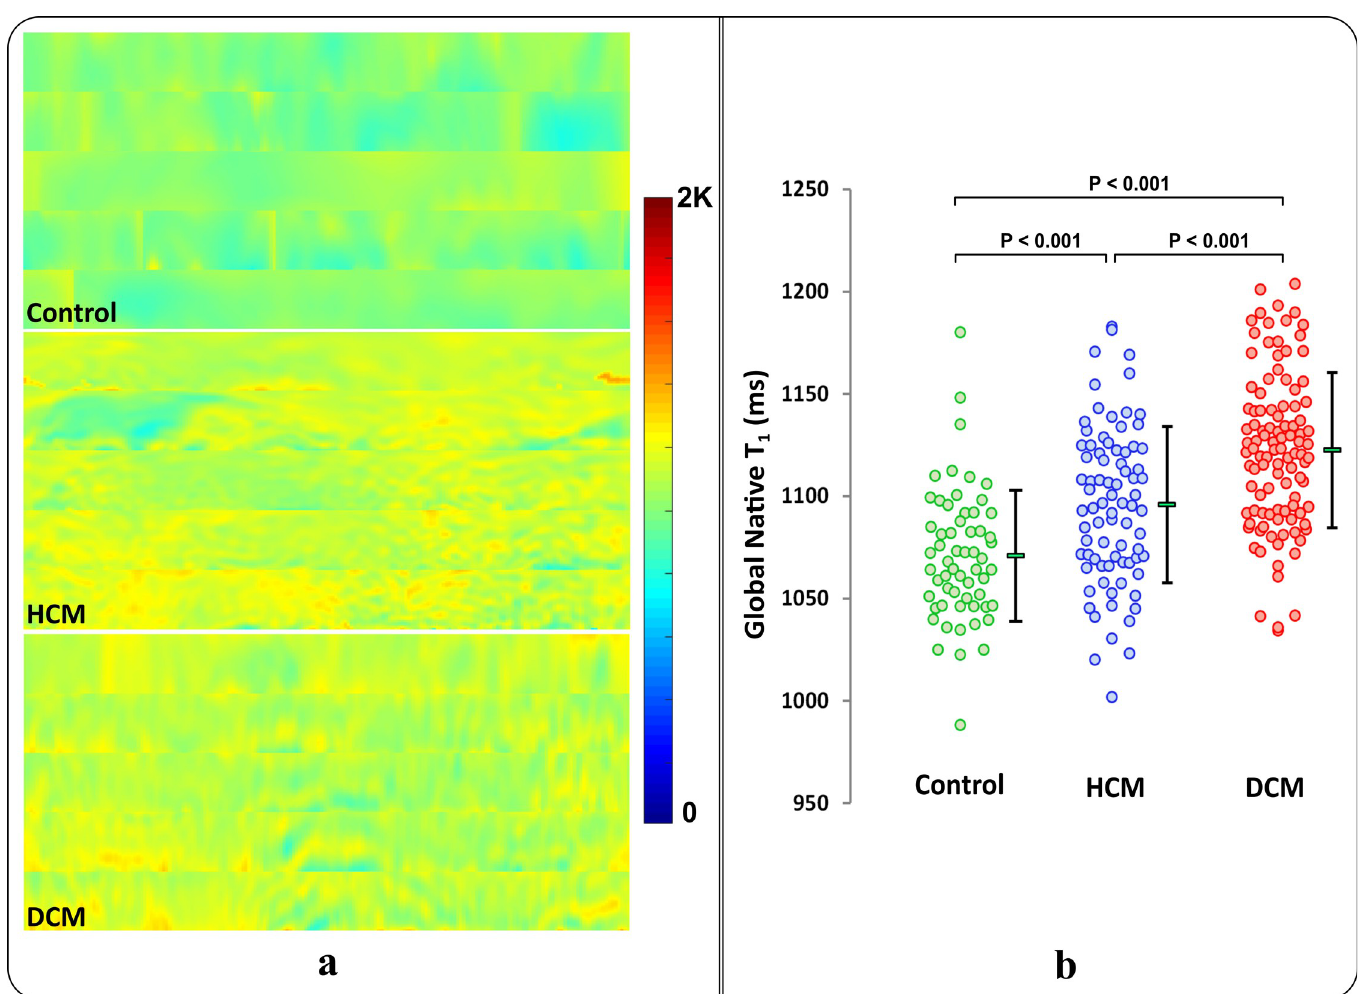
Fig 2. Myocardial native T 1 maps. (a) 5 slices, from base to apex, stacked in a rectangular shape to represent one control, one HCM, and one DCM patient, respectively. Control T 1 maps are characterized by a smooth homogeneous profile, while HCM T 1 maps can be identified by patchy patterns in areas with increased wall thickness, reflecting histological changes of the myocardium. DCM T 1 maps are recognized by irregular scattered patches of increased T 1 values. (b) Myocardial global native T 1 values measured over 5 slices for the three cohorts: control (green), HCM (blue), and DCM (red) from the training dataset. Each dot represents data from an individual subject with the corresponding mean and standard deviation for each cohort.